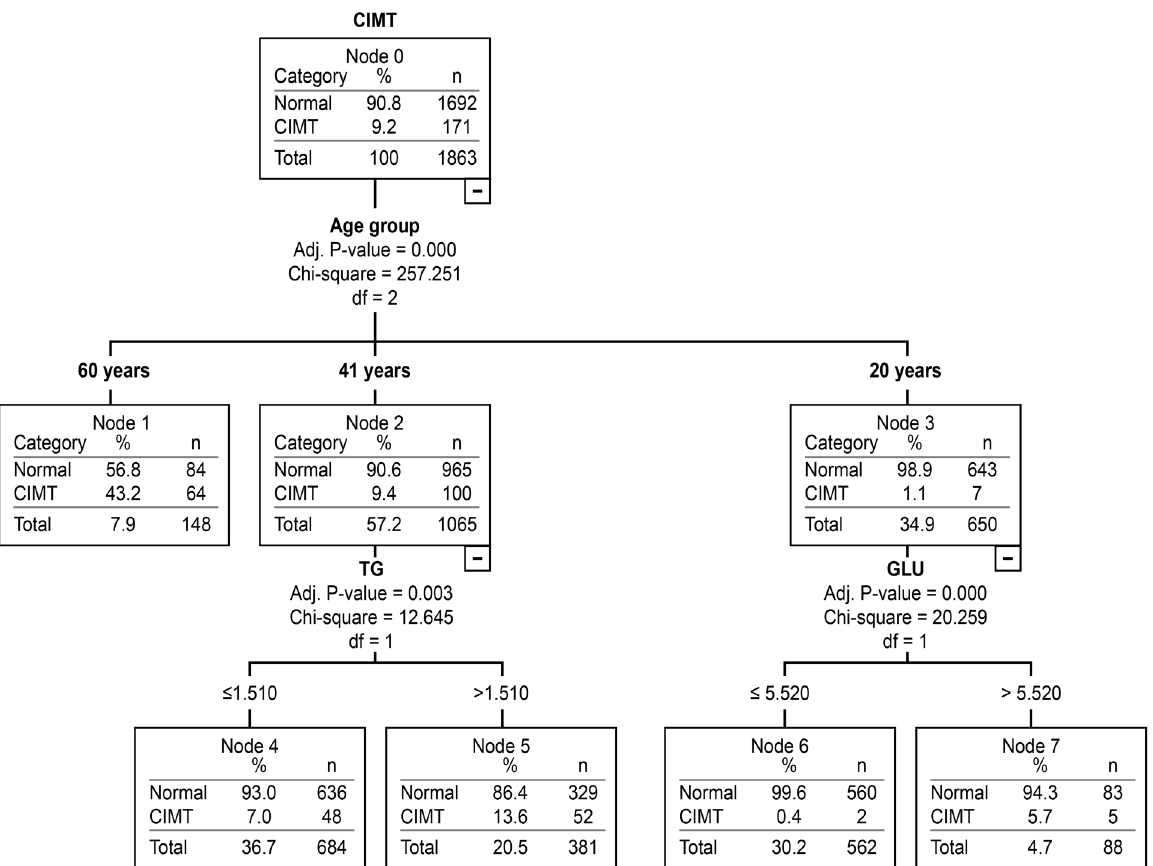
Figure 3. The assessment of traditional risk factors for carotid atherosclerosis in women in different age groups using decision tree